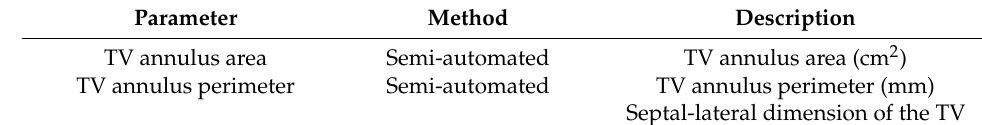
Septal-lateral dimension of the